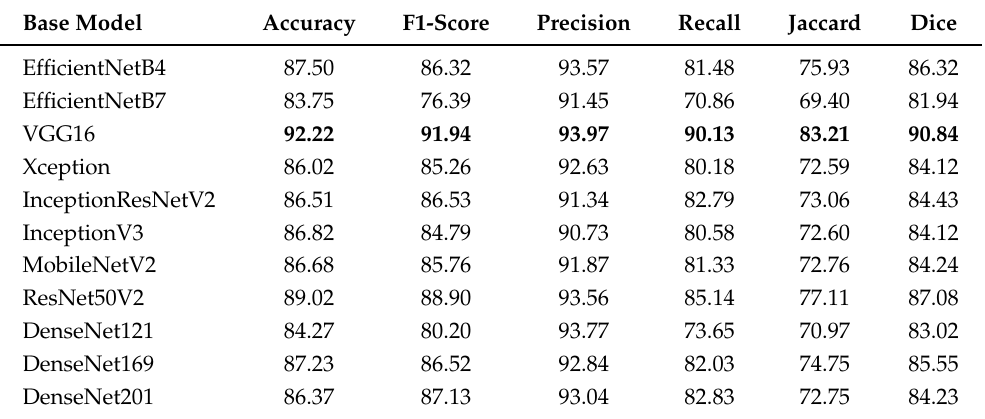
Table 1. Classification performance (%) of the examined deep neural network architectures following the baseline approach. Base Model Accuracy F1-Score Precision Recall Jaccard Dice EfficientNetB4